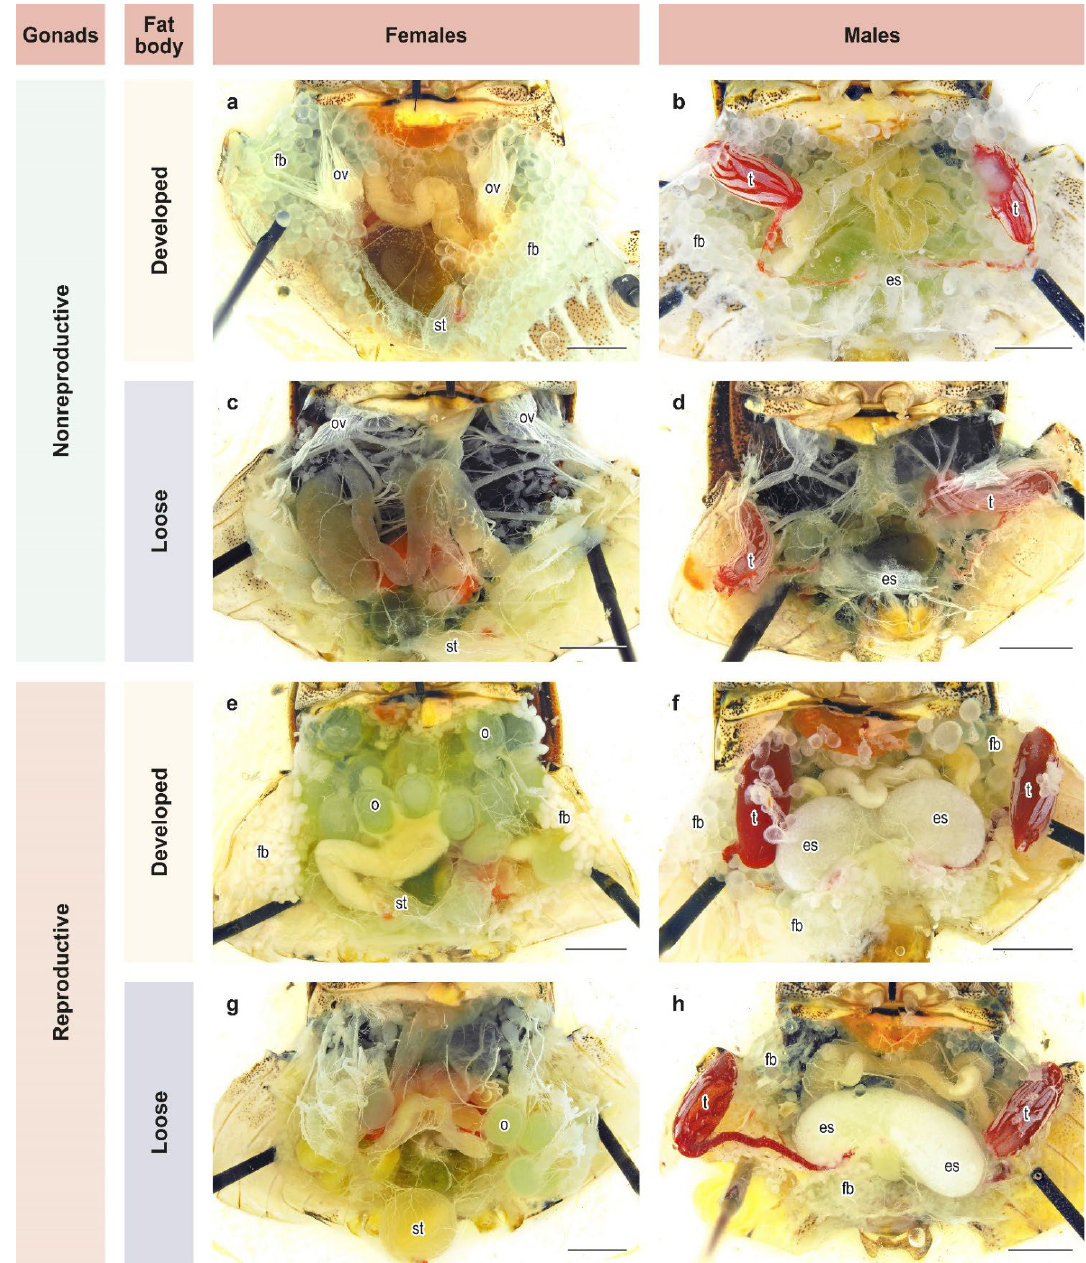
Figure 2. State of development of gonads and fat bodies in females and males of Halyomorpha halys . ( a – h ) different combinations of states of gonads and fat body in females and males, see text for details. Letters of references: es, ectodermal sacs; fb, fat body; o, ovaries; ov, ovarioles; st, sperma- theca; t, testes. Scale bar = 2 mm. Photos: K.